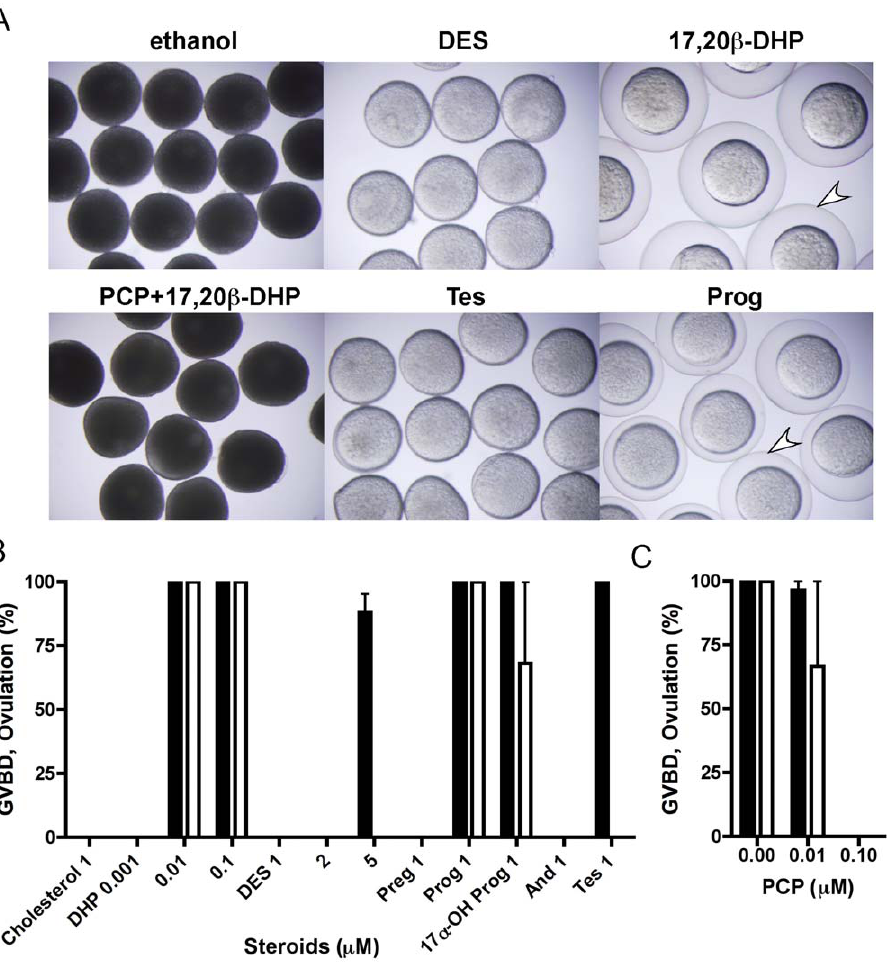
Figure 1. Environmental agents induce and prevent fish oocyte maturation and ovulation. Oocytes were prepared from female zebrafish after incubation with each compound for four hours. The morphology of oocytes was photographed (A); 0.01% ethanol, 5 m M DES, 0.01 m M 17,20 b - DHP, 0.5 m M PCP with 0.01 m M 17,20 b -DHP, 1 m M Tes and 1 m M Prog. Oocytes became transparent after treatment with 17,20 b -DHP, DES, Prog or Tes but remained opaque following treatment with ethanol or PCP with 17,20 b -DHP. A fertilization membrane developed in oocytes ovulated by 17,20 b - DHP or Prog treatment, as indicated by the arrow. (B) Effect of various compounds on the in vivo induction of GVBD and ovulation. Each compound was added into the water at a final concentration of 1 mM except 17,20 b -DHP (0.001, 0.01 or 0.1 m M) and DES (1, 2 or 5 m M). After four hr incubation, %GVBD (closed column) and %ovulation (open column) was determined by scoring oocytes that became transparent and formed a fertilization membrane. (C) Inhibition of in vivo oocyte maturation by PCP. PCP was added to the indicated concentrations, and then maturation induced by 0.01 m M of 17,20 b -DHP. After further four hr incubation, %GVBD and %ovulation was assessed by scoring the oocytes. Each value represents the mean of data from three different females. Vertical lines indicate standard